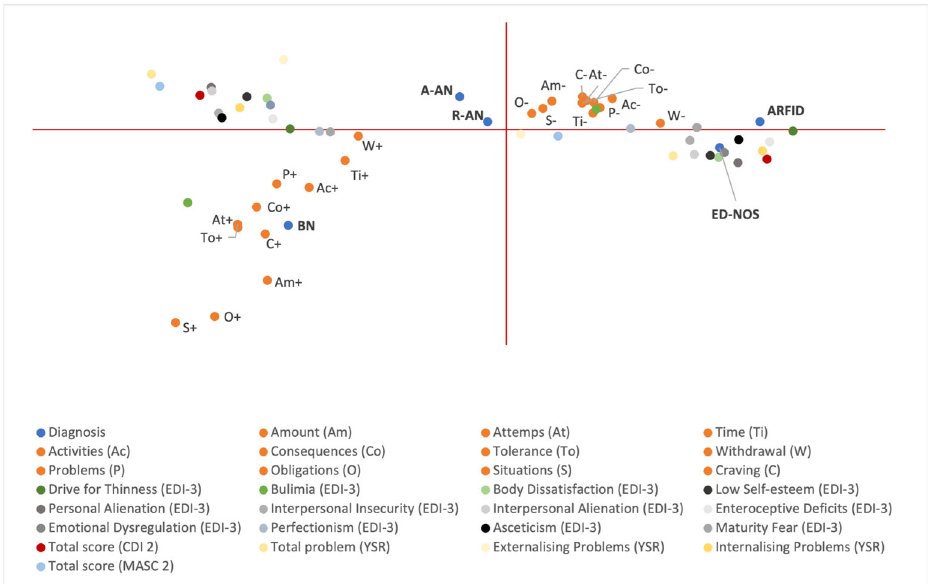
Figure 2. Multiple correspondence analysis using FA symptoms, ED diagnosis, and psychopathological scores. As only one patient was diagnosed with binge eating disorder and one with binge purging ‐ anorexia nervosa, these subgroups were excluded from the MCA analysis due to an insufficient number of patients. + and ‐ correspond to positivity and negativity to FA symptoms, respectively. A ‐ AN, atypical anorexia nervosa; ARFID, avoidant restrictive food intake disorder; BN, bulimia nervosa; ED ‐ NOS, eating disorder not otherwise specified; EDs, eating disorders, R ‐ AN, restrictive anorexia nervosa.